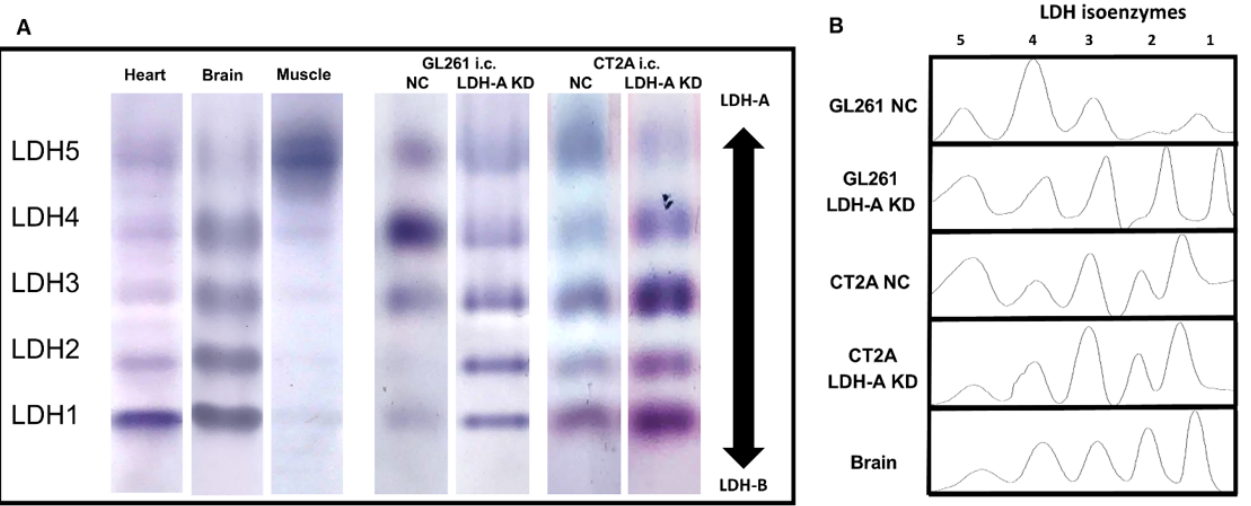
Figure 2. LDH zymograms of i.c. GL261 and CT2A tumors. Native-polyacrylamide gel electrophoretic patterns of i.c. GL261 and CT2A tumors (both LDH-A KD and control NC), as well as heart, brain, and skeletal muscle were obtained ( A ), corresponding LDH isoform analysis ( B ); n = 5 independent studies.